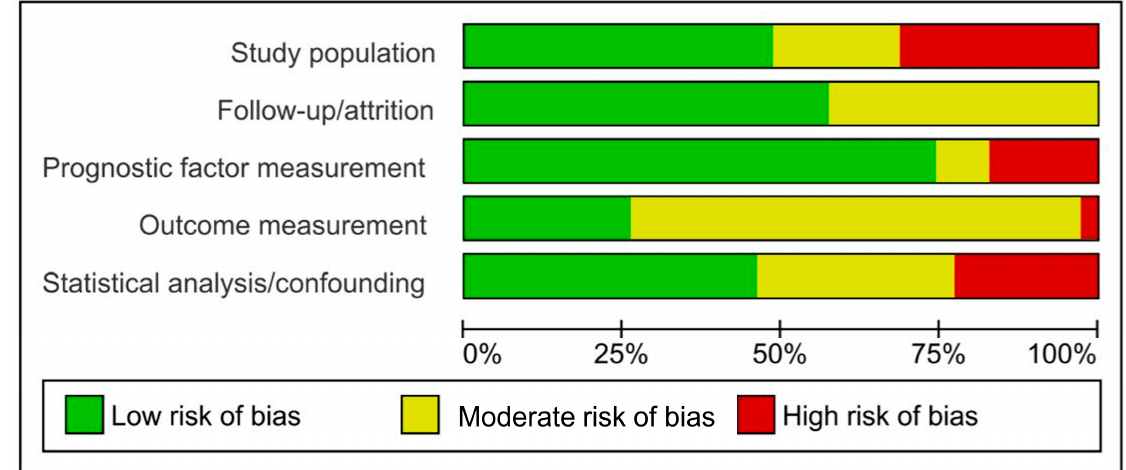
Figure 2. Graphical representation of risk of bias assessment (RoB) for included studies. Quantification of the RoB in each study domain, assessed with the QUIPS tool. Green, yellow, red represent low, moderate and high RoB, respectively.